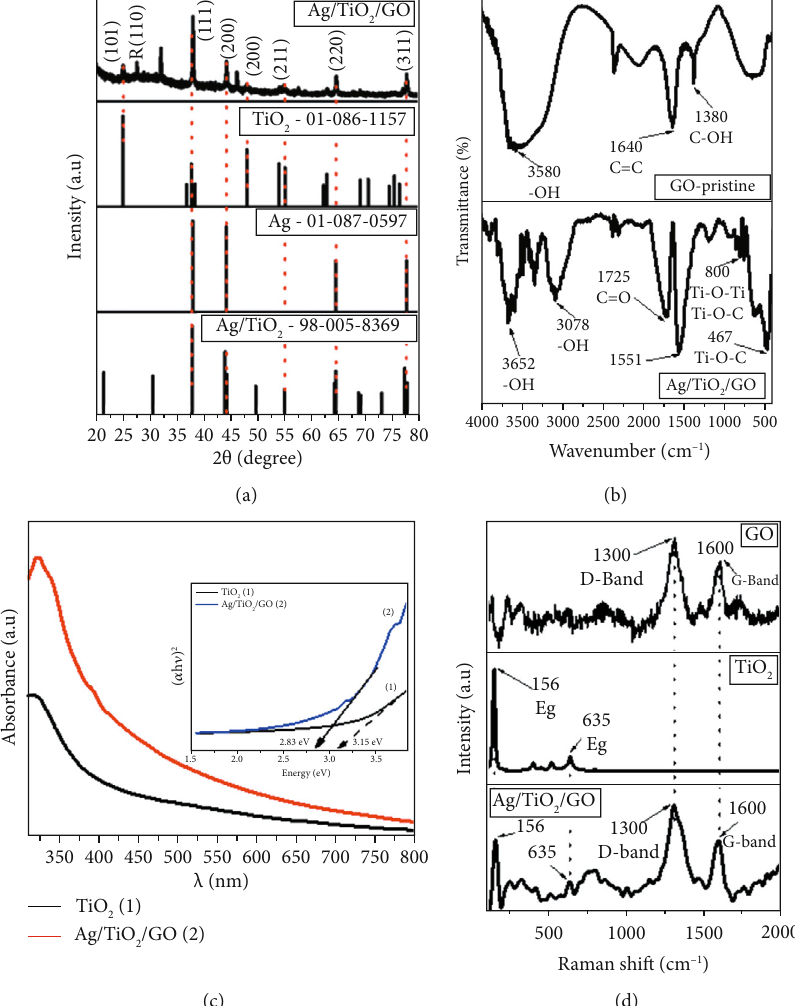
Figure 2: XRD pattern of Ag/TiO Ag/TiO /GO (c), Raman spectra of GO, TiO 2